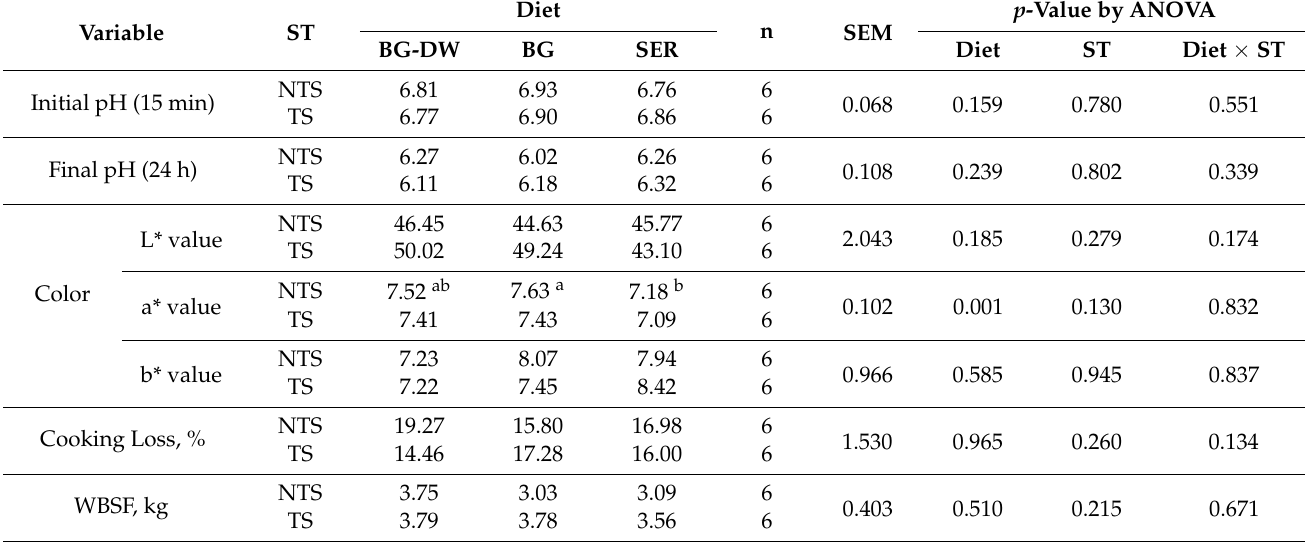
Table 5. Effects of diet (BG-DW: bermudagrass hay—dewormed; BG: bermudagrass hay; SER: sericea hay) and stress treatment (ST: Non-Transported, NTS; Transported, TS) on Longissimus muscle pH, color, cooking loss, and Warner-Bratzler Shear Force (WBSF) value in